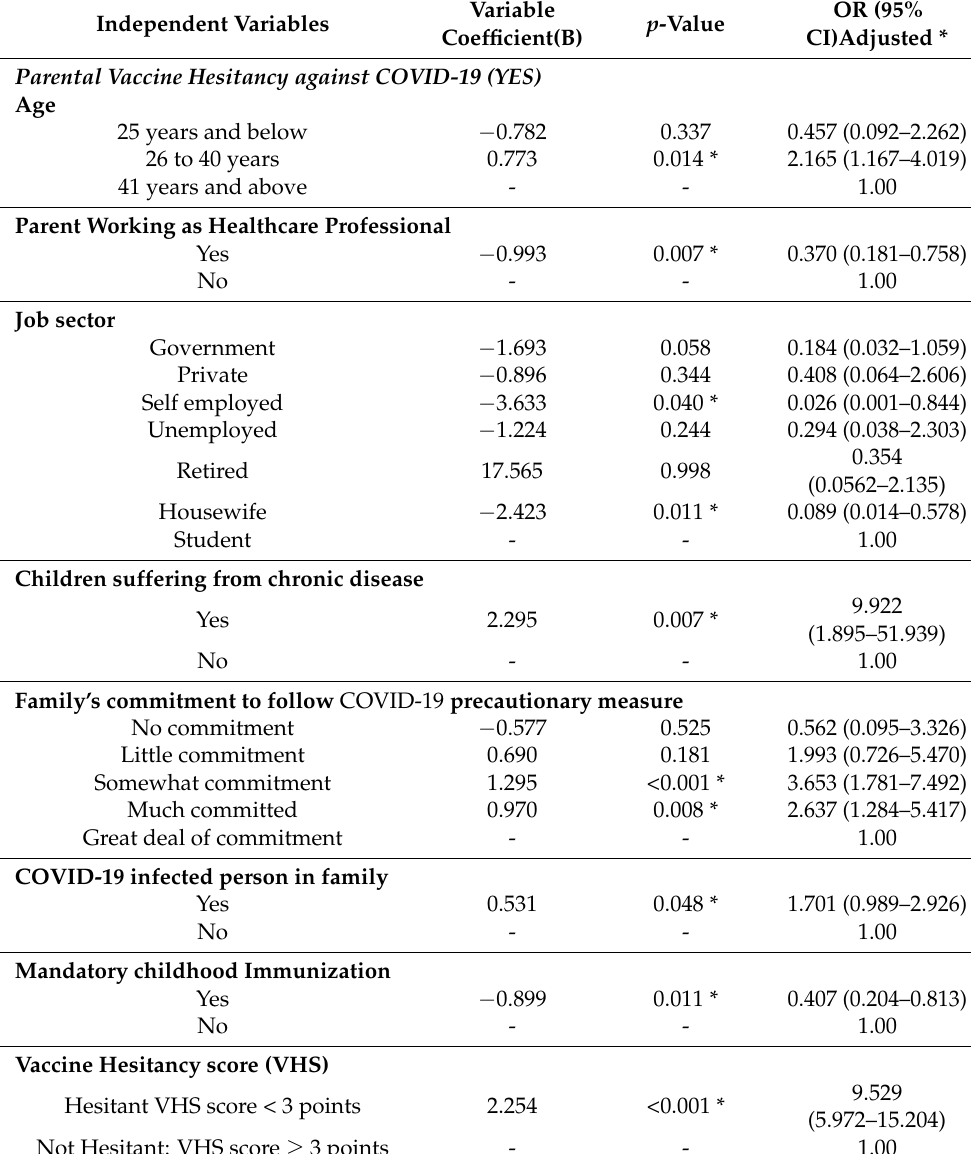
Table 5. Identifying the variables associated with parental intention to vaccinate their